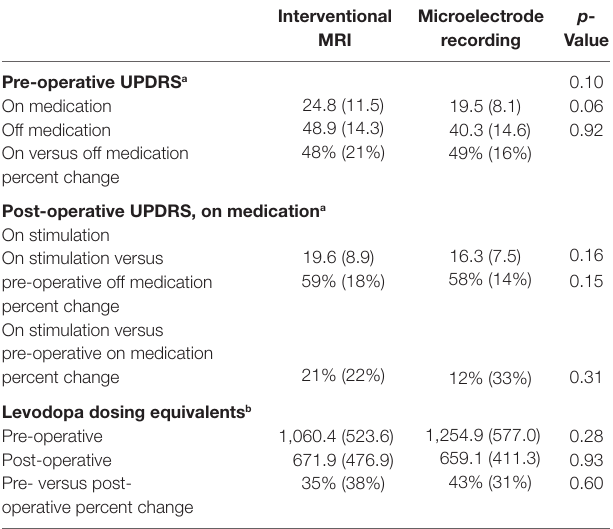
TaBle 1 | Means, SDs, and significance level of pre- and post-operative UPDRS scores and levodopa dosing